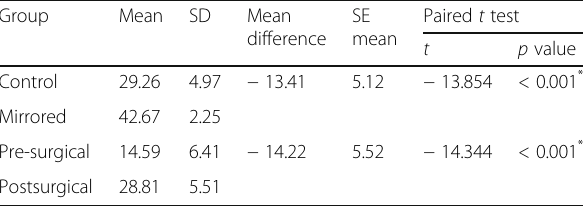
Table 2 Comparison between control and mirrored groups and between pre-surgical and postsurgical groups Group